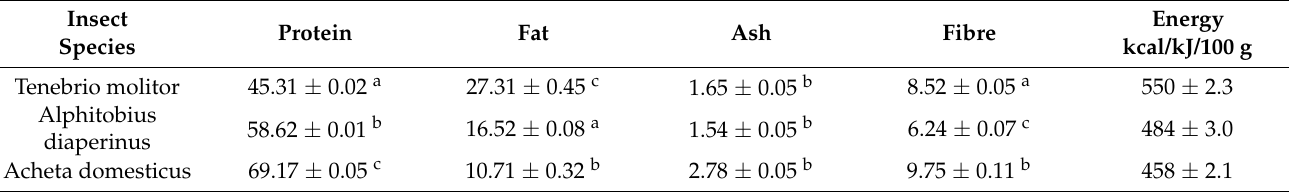
Table 1. Nutritional value of freeze-dried edible insects (g × 100 g − 1